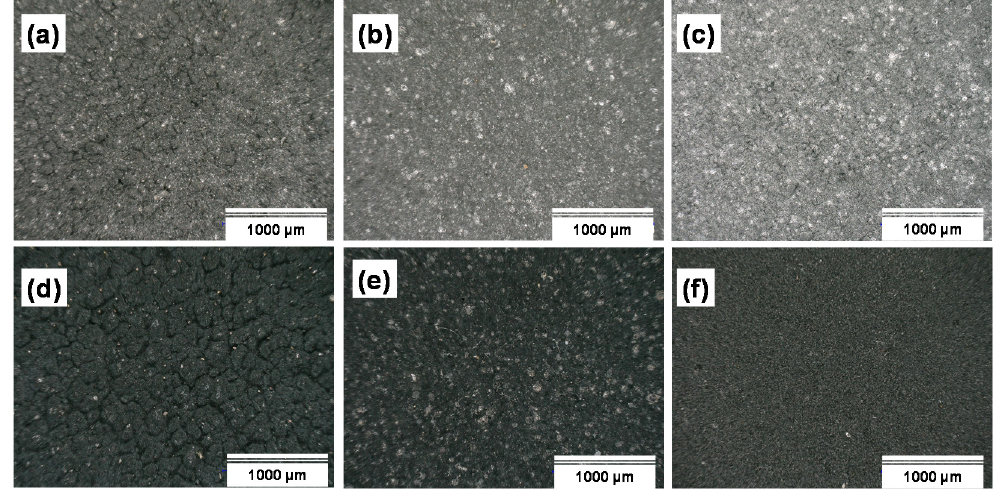
Figure 17. Optical microscopic images of the plasma synthesized coatings for ( a ) Ti, ( b ) carbon steel and ( c ) Mo; the coated samples after corrosion test for ( d ) Ti, ( e ) carbon steel and ( f ) Mo.